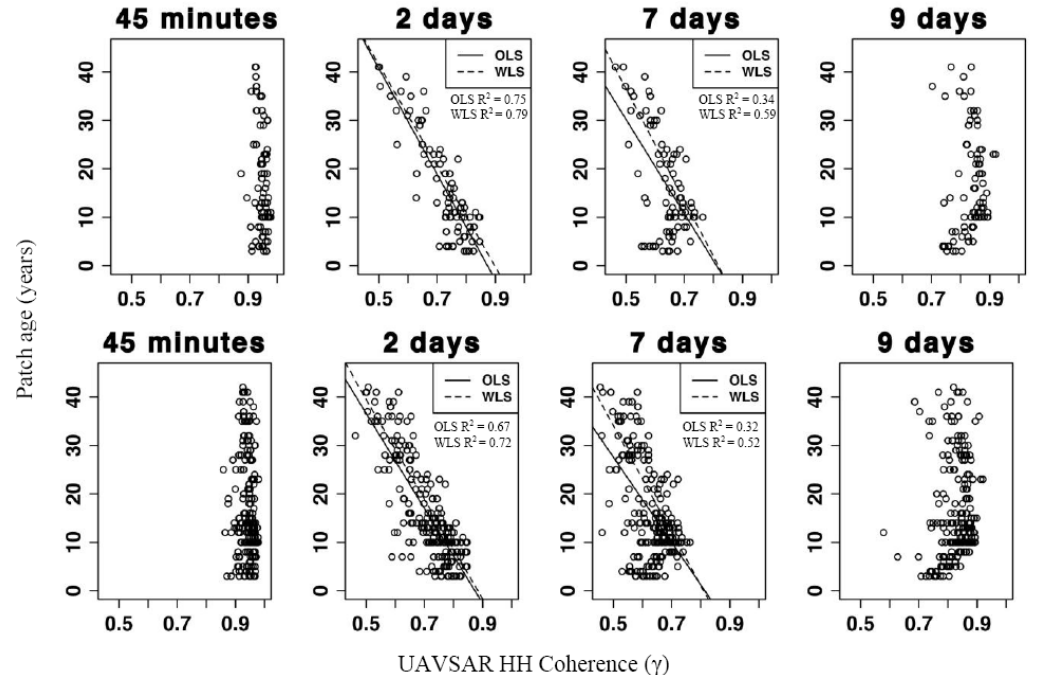
Figure 6. Forest patch age modeled as a function of UAVSAR interferometric coherence. Values were calculated with zero spatial baseline and HH polarization. Minimum overlap with UAVSAR swath is 5 ha (top row) and 1 ha (bottom row). Line fits are added to significant models (see Tables 3 and 4 for model parameters). OLS = ordinary least squares, WLS = weighed least squares. Note the broader dynamic range for the 2-day pair.